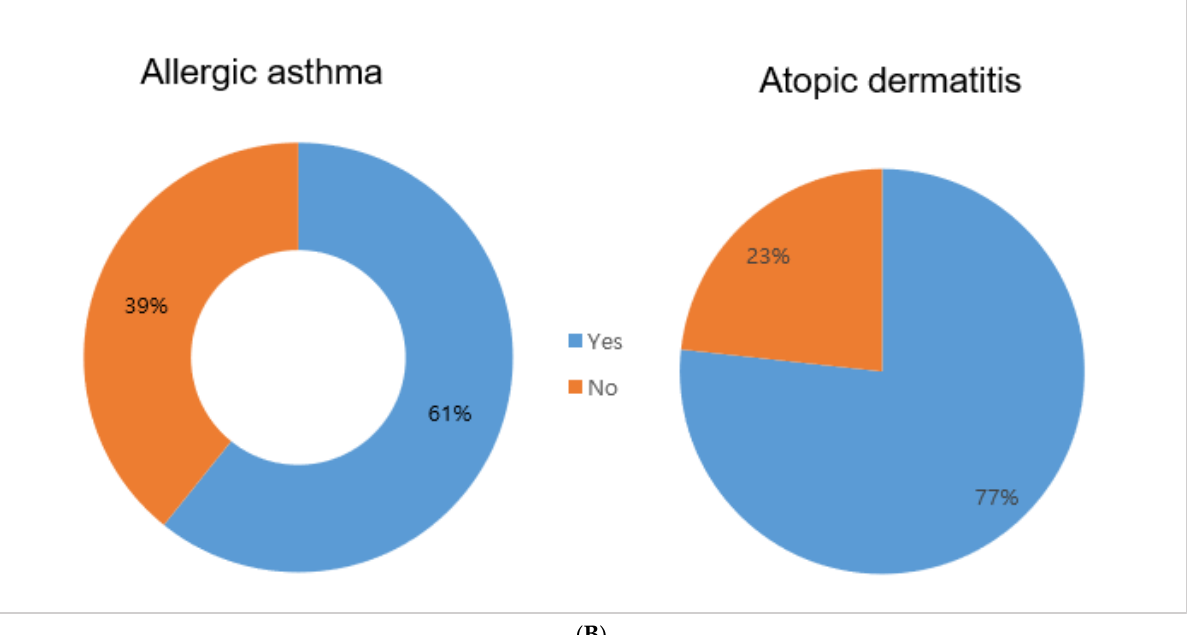
Figure 2. ( A ). Frequency distribution of allergic diseases by year based on the KNHANES data 2015–2019. ( B ). Percentage distribution of allergic asthma and atopic dermatitis. Table 1. General characteristics and distribution among children with allergic diseases ( n =